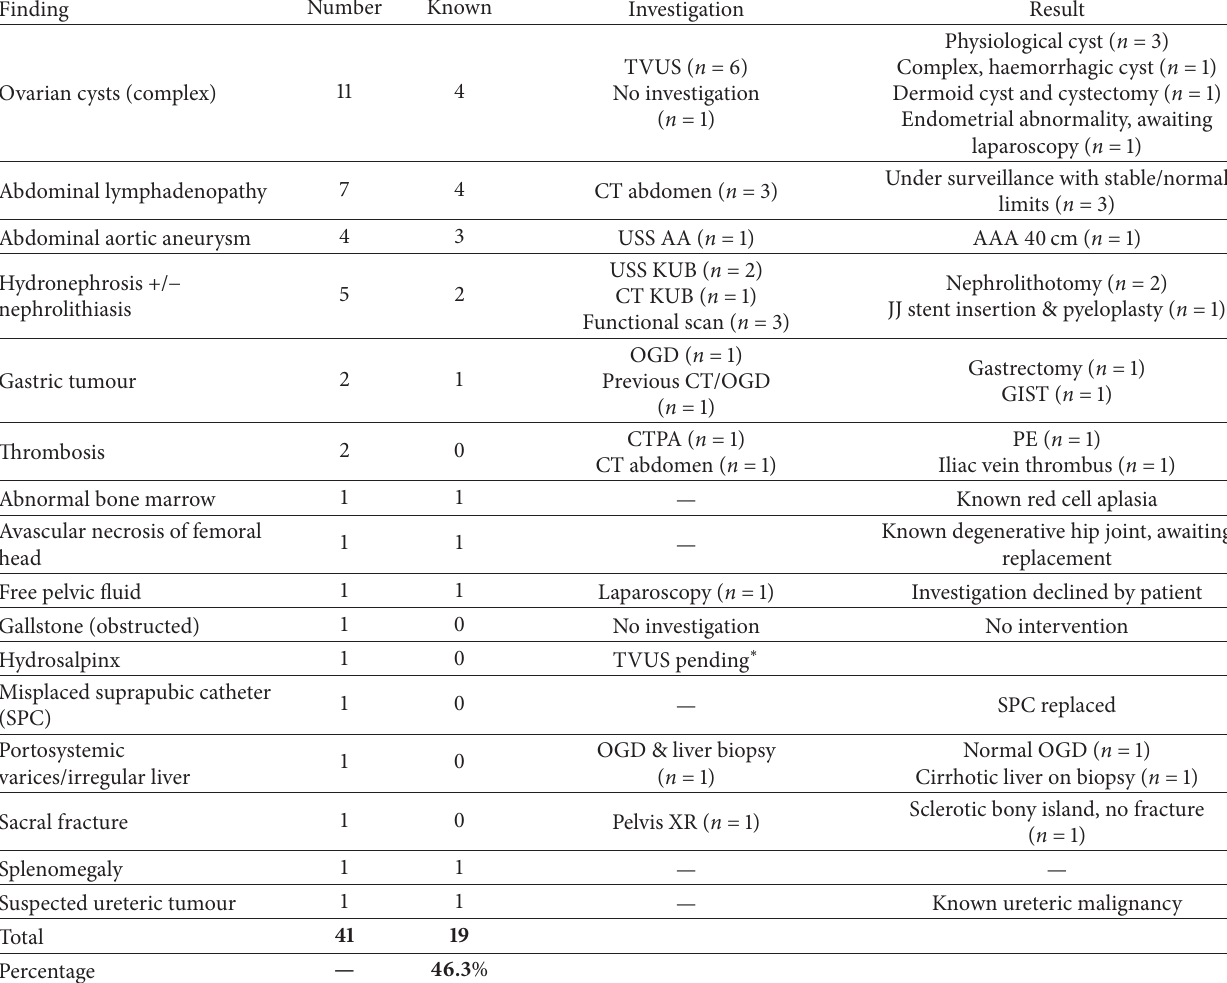
Table 4: Significant extraenteric findings, investigations, and results.